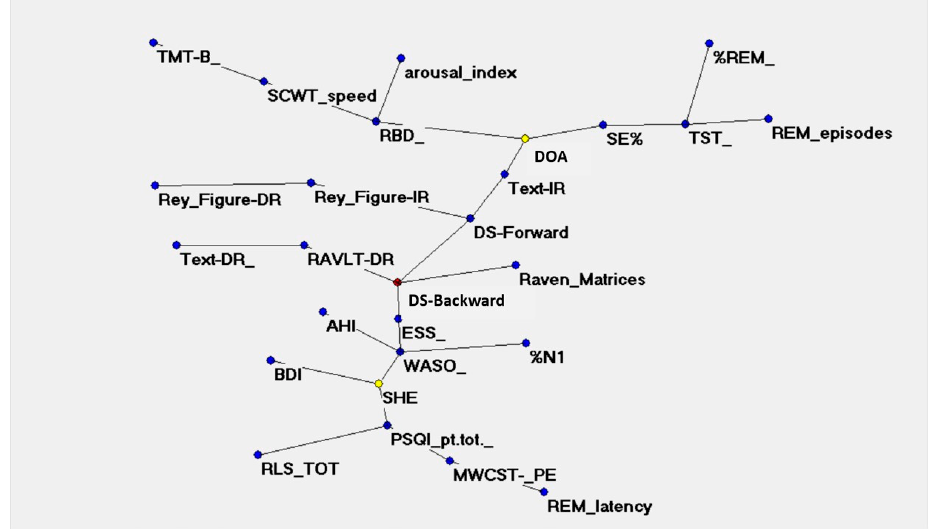
Figure 1. The figure shows the connections between the sleep and the cognitive